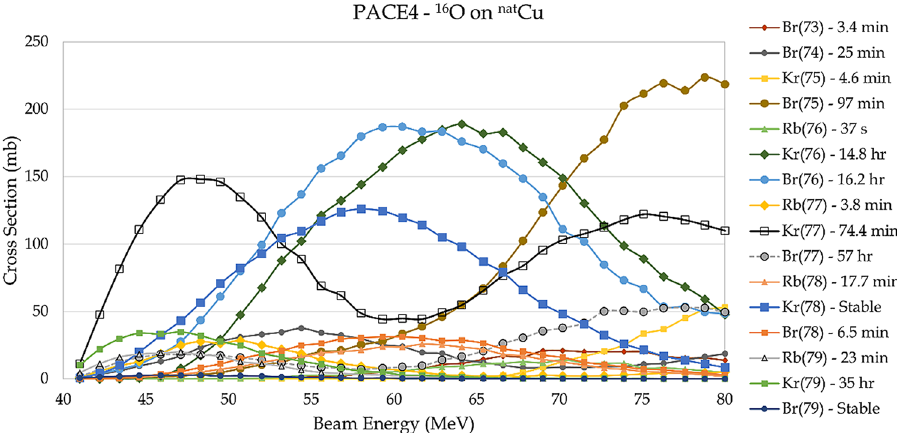
Figure 2. PACE4 predicted cross sections for 16 O on nat Cu as a function of laboratory bombarding energy. All relevant isotopes are shown with their respective half-lives. The double-humped structure is the result of Q-value differences between reactions on 63 Cu and 65 Cu. The mass 77 and 76 decay chains are both produced strongly.